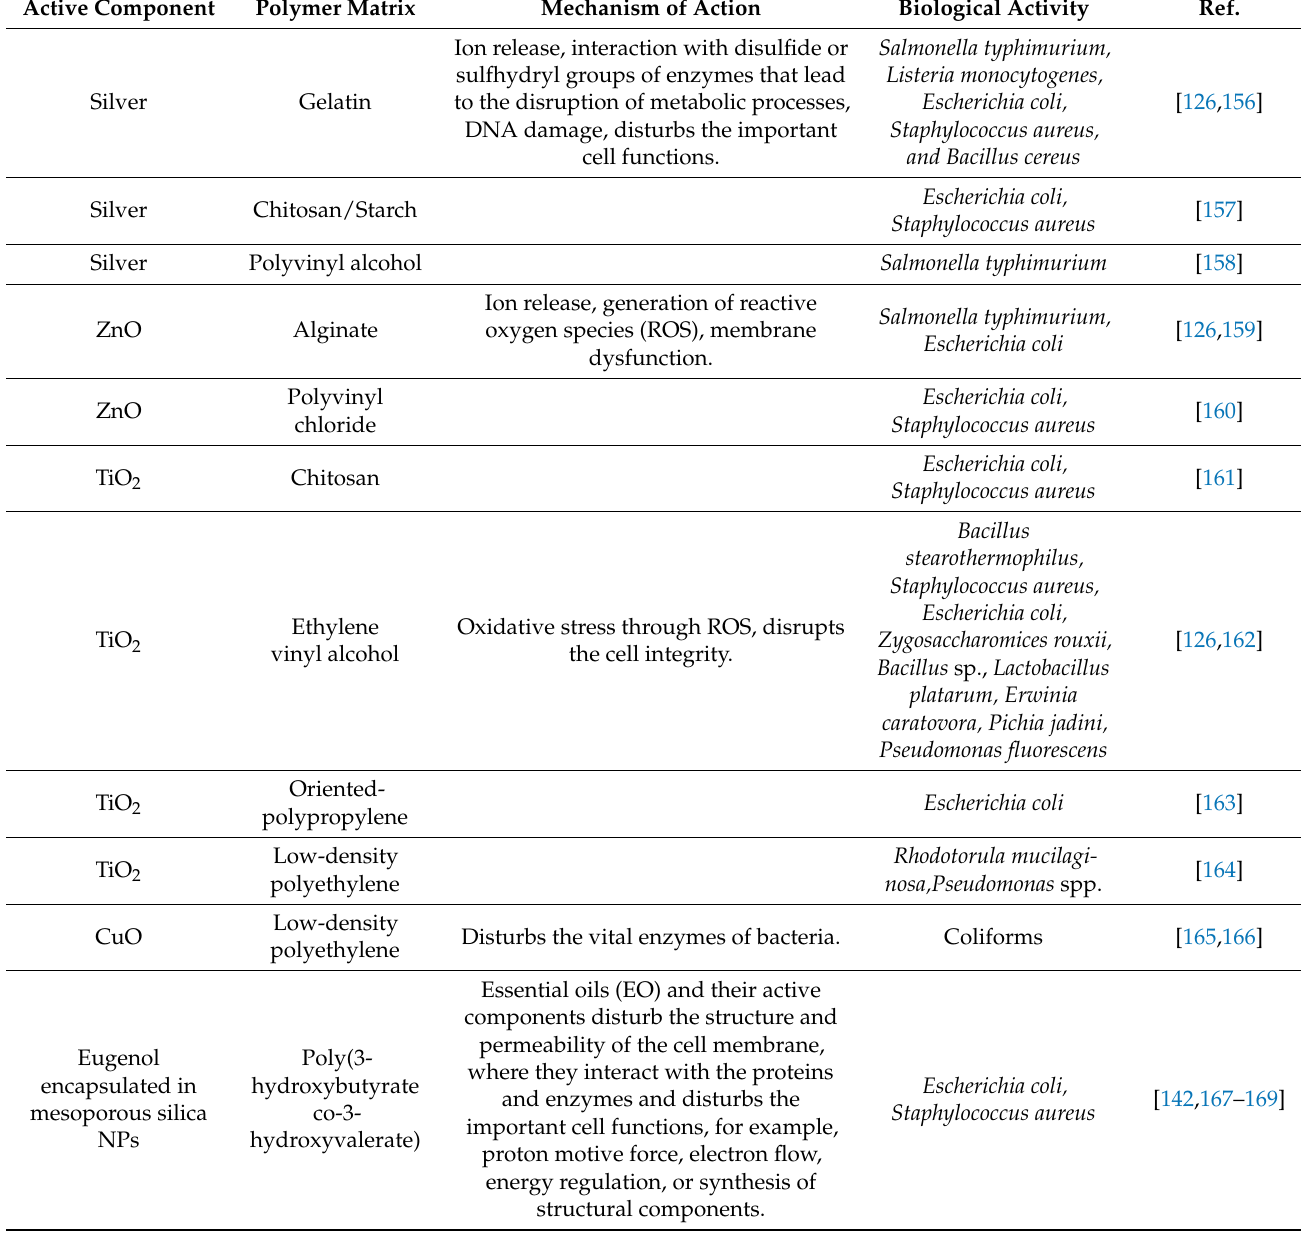
Table 3. Examples of antimicrobial properties of the polymer nanocomposites. Active Component Polymer Matrix Mechanism of Action Biological